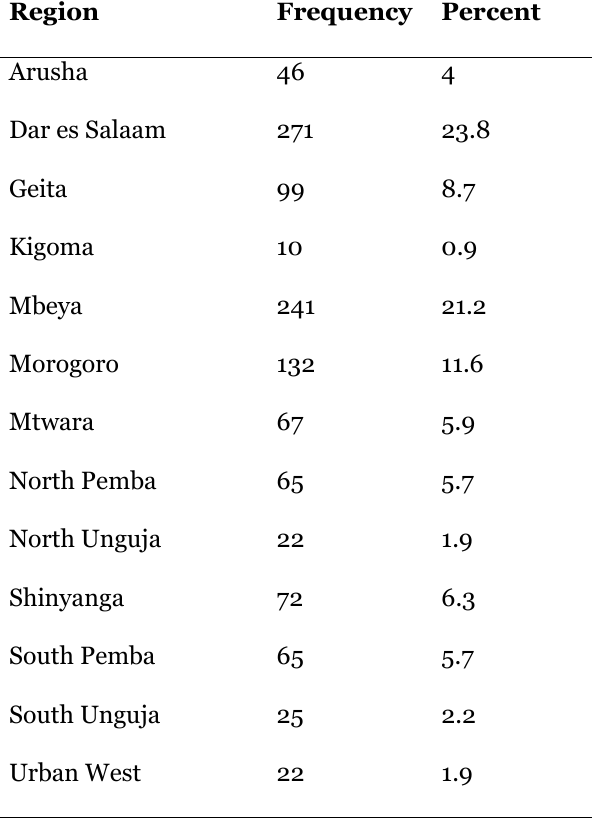
The Distribution of Respondents Per Region